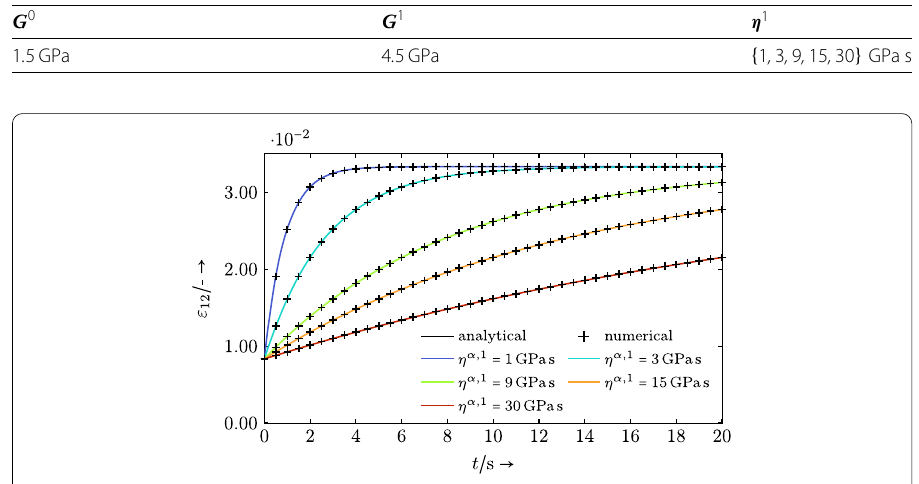
Fig. 4 Creep test, one phase: Comparison of numerical and analytical solution